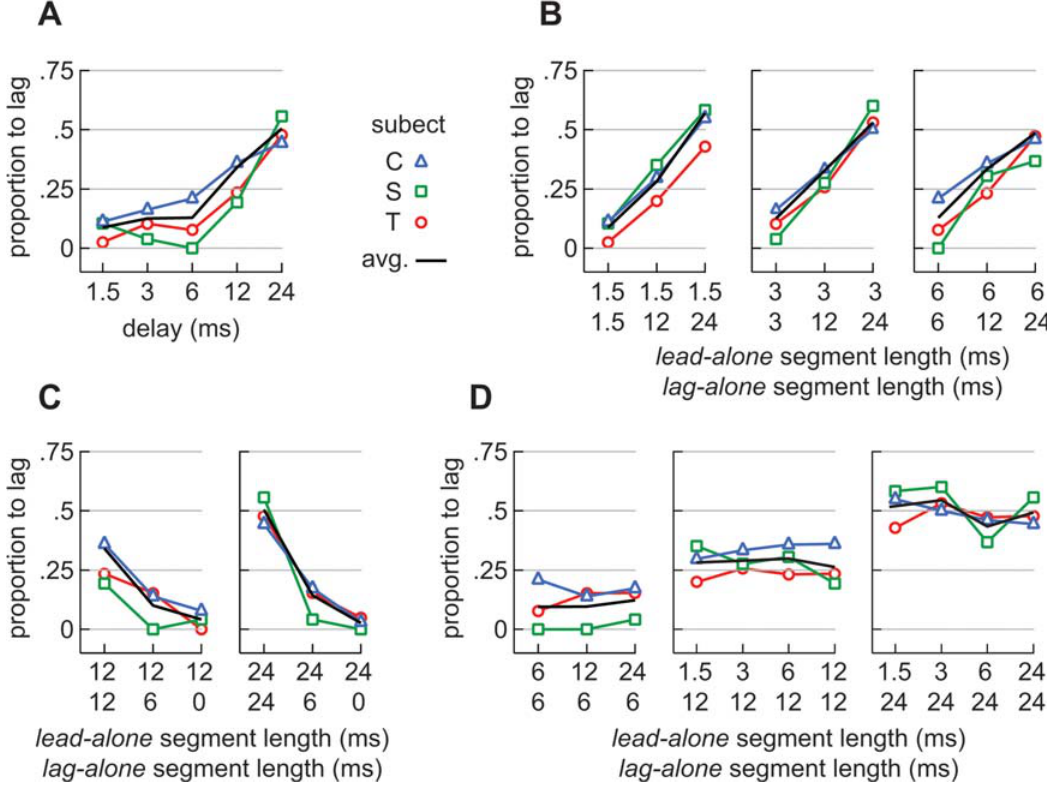
Figure 6. Proportions of trials on which saccades were lag-directed for three birds. ( A ) Proportion of lag-directed saccades in the standard paradigm plotted against the lead/lag delay. The black, dashed, line in this and other plots shows the average of all three subjects. ( B ) Proportion of lag-directed saccades observed when lag-alone segments were experimentally lengthened. At each point along the abscissa, the number on top indicates the length of the lead-alone segment (onset-delay). The number underneath indicates the length of the lag-alone segment. ( C ) Proportion of lag-directed saccades observed when lag-alone segments were experimentally shortened. ( D ) Proportions of lag-directed saccades shown here have been regrouped so that the length of the lag-alone segment is constant within each panel.